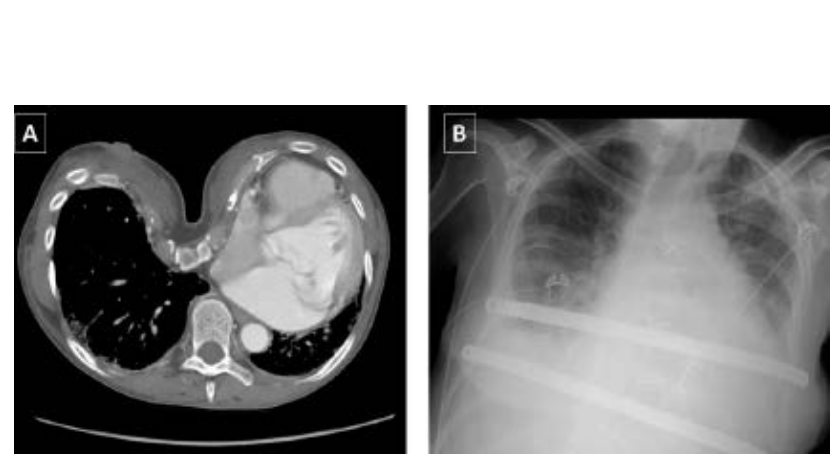
Figure 9. Pre-operative CT image of a severe pectus excavatum deformity in a Marfan patient requiring an aortic root replacement (A) and following aortic surgery and place- ment of 2 bars concomitantly